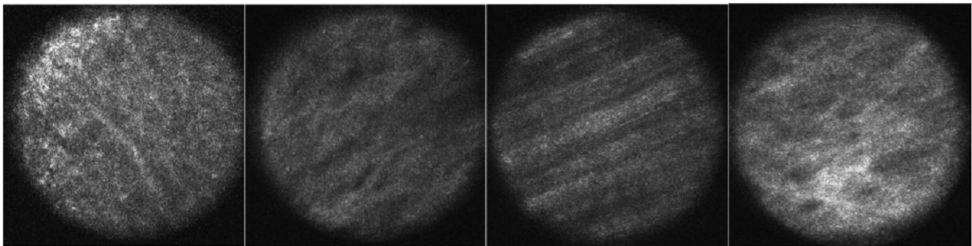
Figure 9. Images of tissue classes in colon cancer. From left to right, benign colon tissue, cancerous colon tissue, benign peritoneum tissue, and cancerous peritoneum tissue. Reproduced with permission from [165].